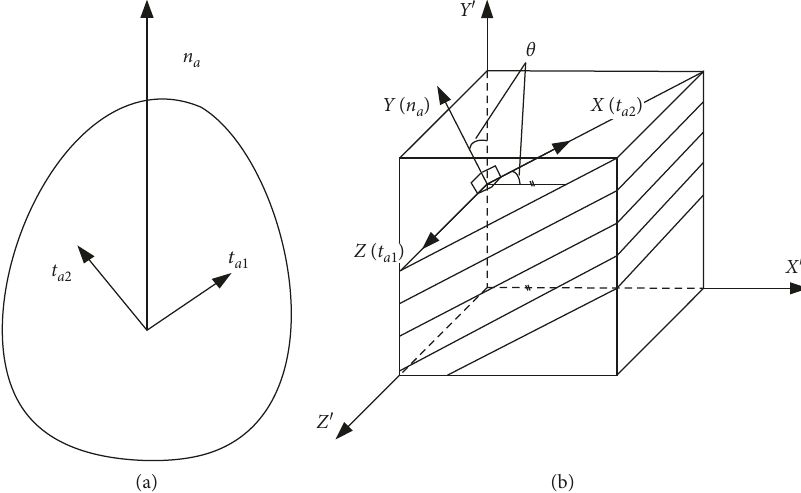
Figure 11: Coordinate systems used for transformation law of a layered rock mass. (a) Vectors of bedding plane. (b) Coordinate systems.